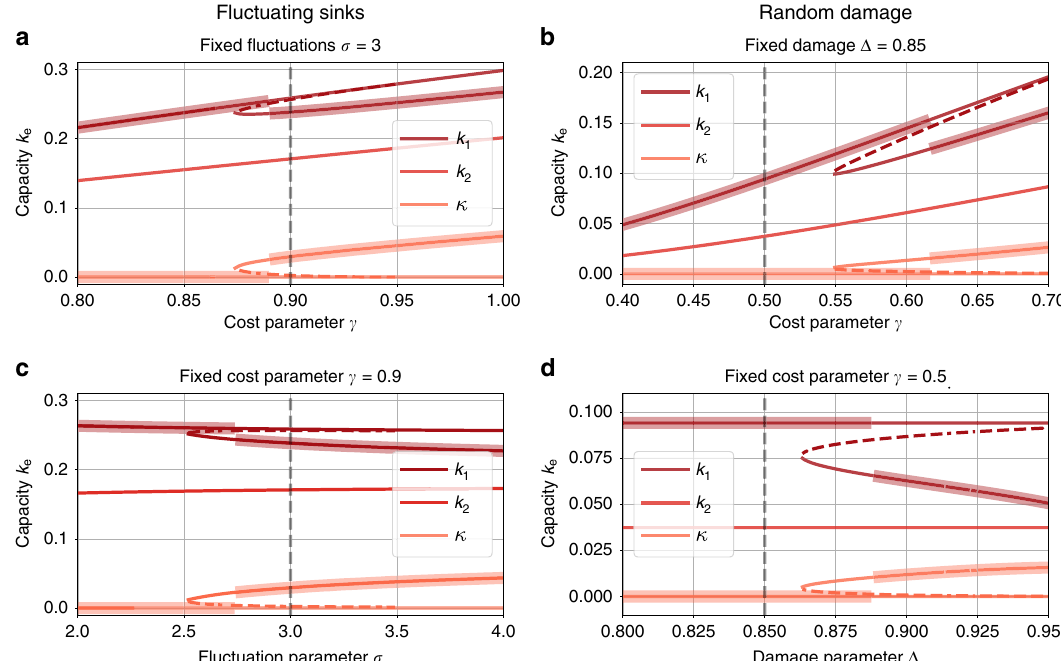
Fig. 3 Discontinuous transition in dissipation minimum appears throughout models and parameters. Capacities at the global minimum (thick lines) show a discontinuity for different models when analysing the topology shown in Fig. 2a. a , c We analyse the edge capacities k e at the local minima (straight lines) and saddle (dotted lines) for varying cost parameter γ ( a ) and varying fl uctuation parameter σ ( c ) for the fl uctuating sink model with fl uctuation mean μ = − 1 and total capacity K = 1. For both parameters, the capacity at the loop κ (light orange) undergoes a saddle-node bifurcation which causes a discontinuous transition in the global minima (thick lines) from non-loopy to loopy networks. b , d An analogous saddle-node bifurcation in the capacities k e may be observed in the generalised damaged bond model in terms of both the cost parameter ( b ) and the damage parameter ( d ). For all four plots, dotted black lines denote the matching values in the other